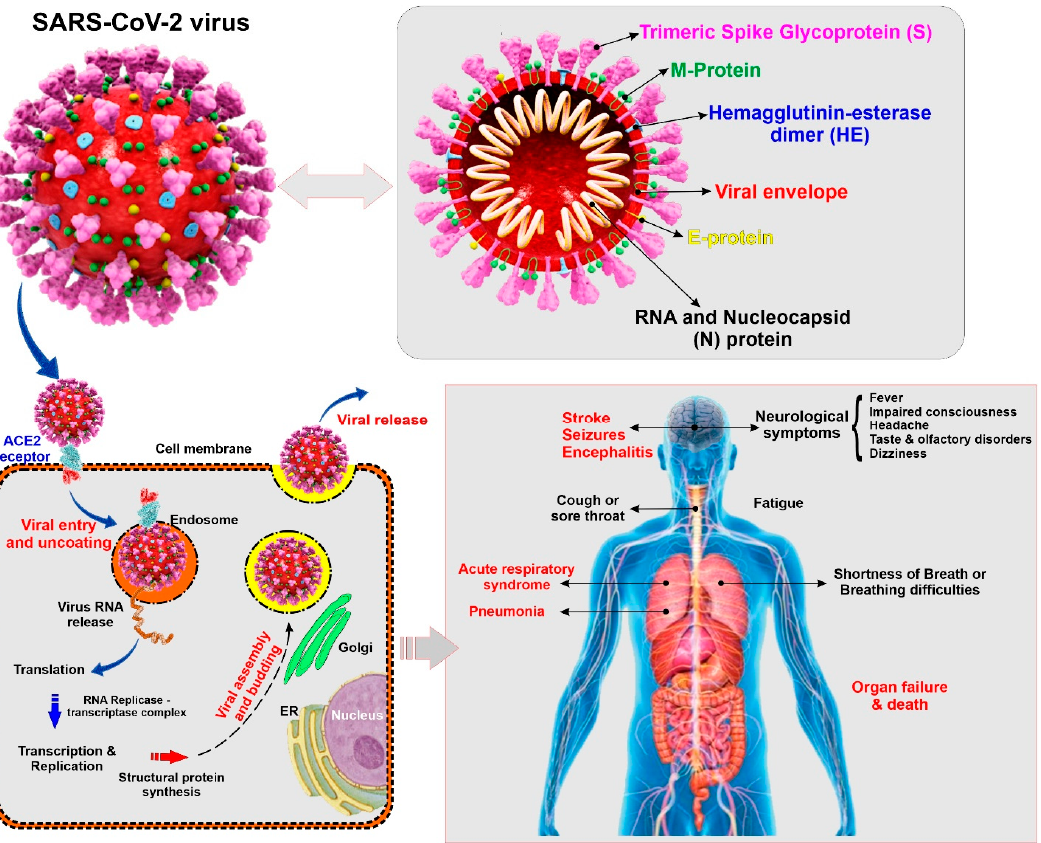
Figure 1. Illustrative view of the SARC-CoV-2 virus structural components and known modality of viral entry into the cells. The scheme also provides a summary panel of the potential health impact on the human body specific to lung and the CNS. (ACE2: Angiotensin converting enzyme 2, ER: Endoplasmic reticulum)